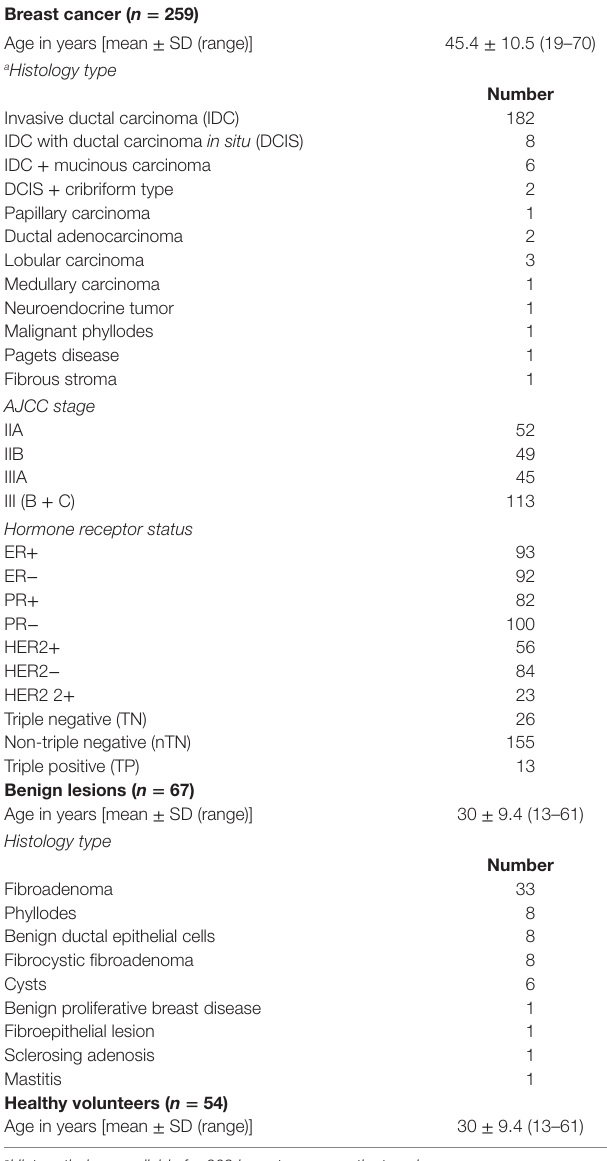
TaBle 1 | Demographic details of subjects. Breast cancer ( n =